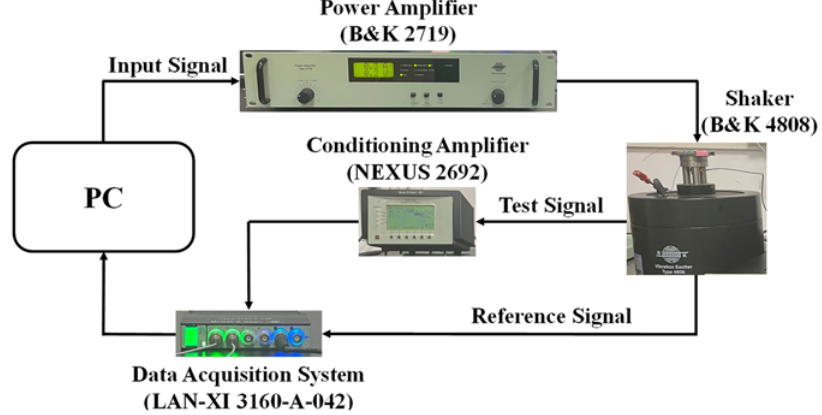
Figure 7. The diagram of the accelerometer vibration experiment setup.